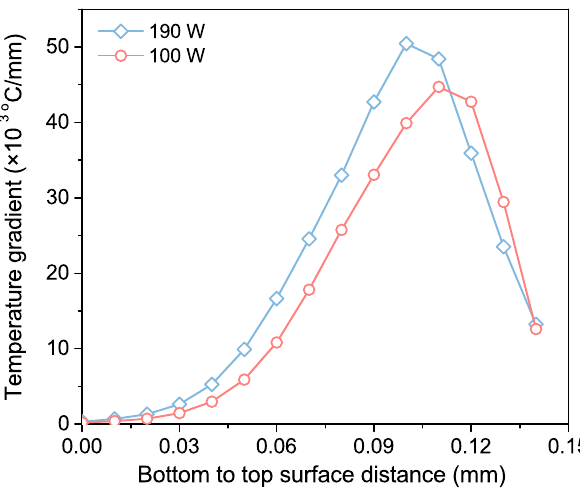
Figure 7. Temperature gradient changes from the bottom to the molten pool surface in the printing depth